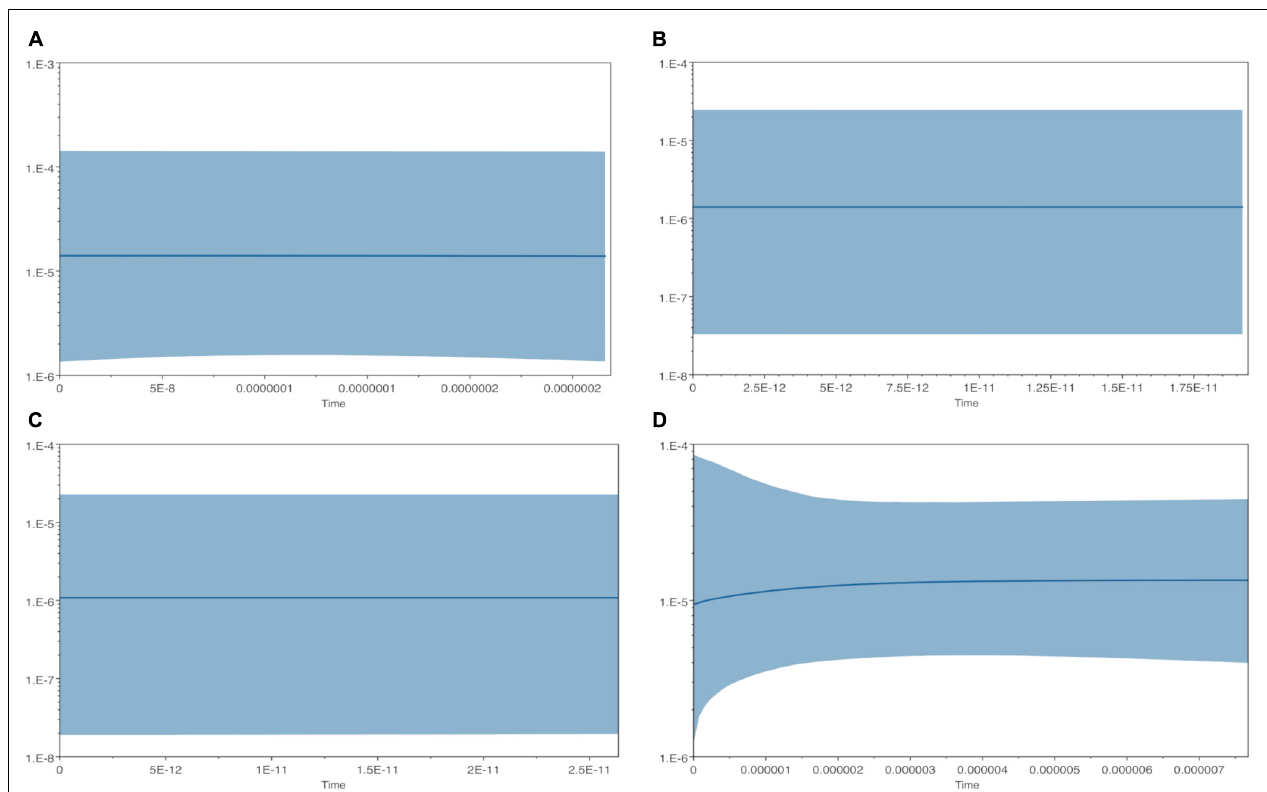
FIGURE 6 | Bayesian Skyline plots derived from cpDNA sequences of Ulmus laevis . The analysis was performed for each population separately. The X -axis is in units of million years ago (Mya) and the Y -axis is the population size, expressed in units of Ne τ , the product of effective population sizes per generation length. The thick solid line represents the mean effective population size N e , while the 95% highest posterior density (HPD) limits are shown by the blue area. (A) France_NE, (B) France_SW, (C) Italy, and (D)